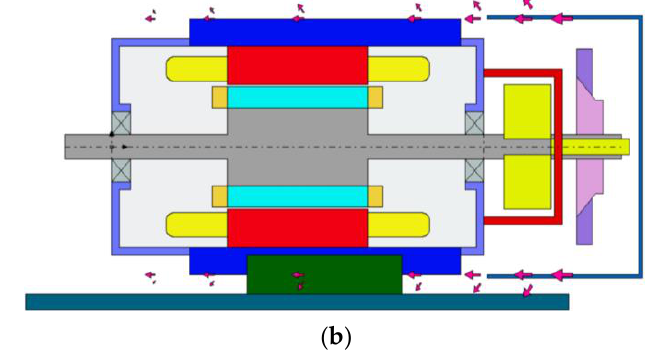
Figure 7. Radial view of fan-cooled motor mainly showcasing the housing type-axial fins (the wind- ings, stator, and rotor) ( a ); axial view of fan-cooled motor depicting air flow coming from fan cooling system through the arrows ( b ).